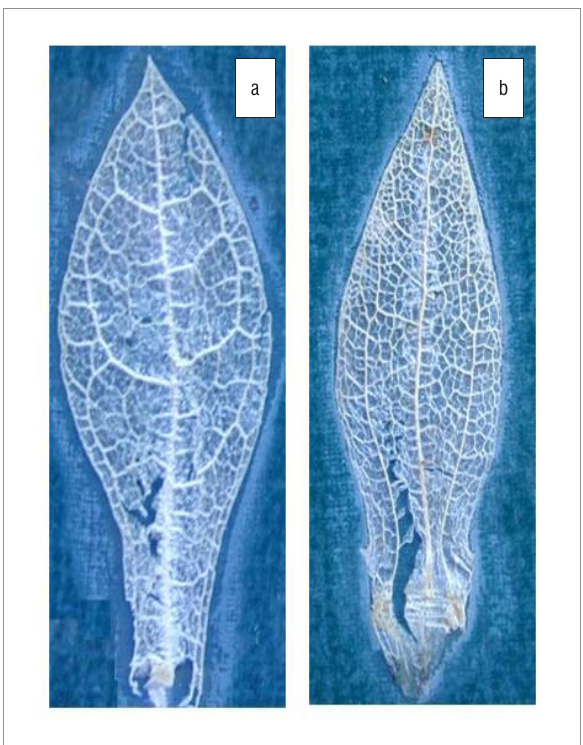
Figure 1 : Sceletium dried leaves showing the venation pattern of (a) emarcidum-type leaves and (b) tortuosum-type